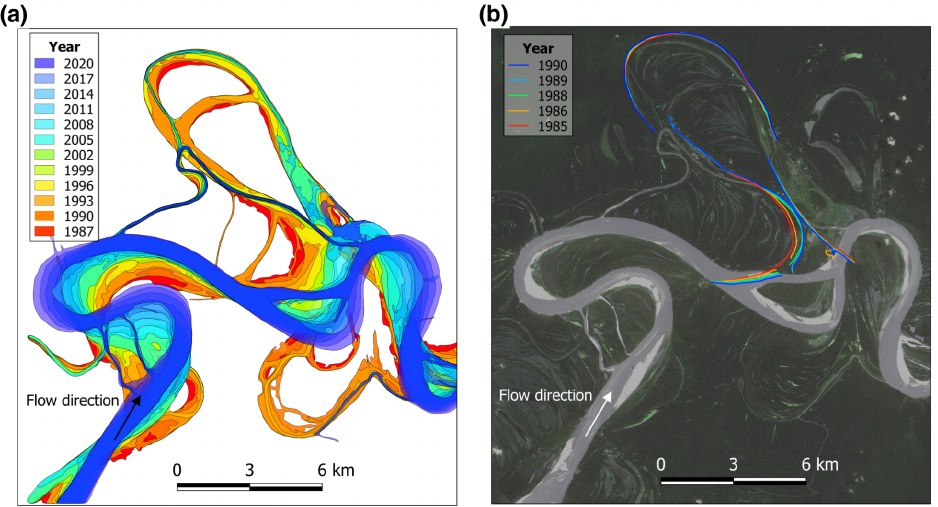
Figure 2. ( a ) Planform migration of the US bend (see Figure 1 for location) from 1987 to 2020. ( b ) The migration of the outer bank from 1985 to 1990, the interval when the neck cutoff